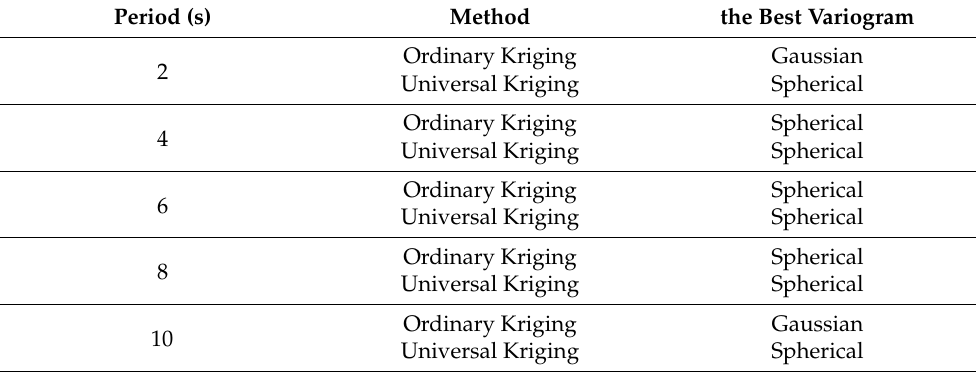
Table 1. The best variogram under different kriging approaches in each period. Period (s) Method the Best Variogram Ordinary Kriging Gaussian 2 Universal Kriging Spherical Ordinary Kriging Spherical 4 Universal Kriging Spherical Ordinary Kriging Spherical 6 Universal Kriging Spherical Ordinary Kriging Spherical 8 Universal Kriging Spherical Ordinary Kriging Gaussian 10 Universal Kriging